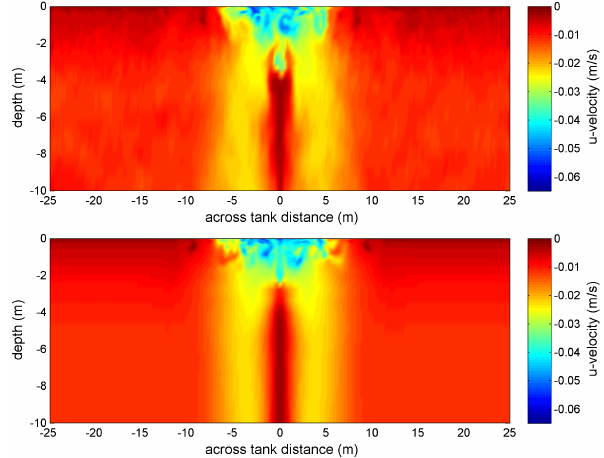
Figure 2. Side view of x velocity (at time t = 575s) for ship wake model without (top panel) and with (bottom panel) ambient stratifi- cation. The stratification appears to affect the spreading of the wake at the surface and to suppress background turbulent fluctuations in the model. Also note that the model shows a region of low velocity at mid-depth, centered below the surface